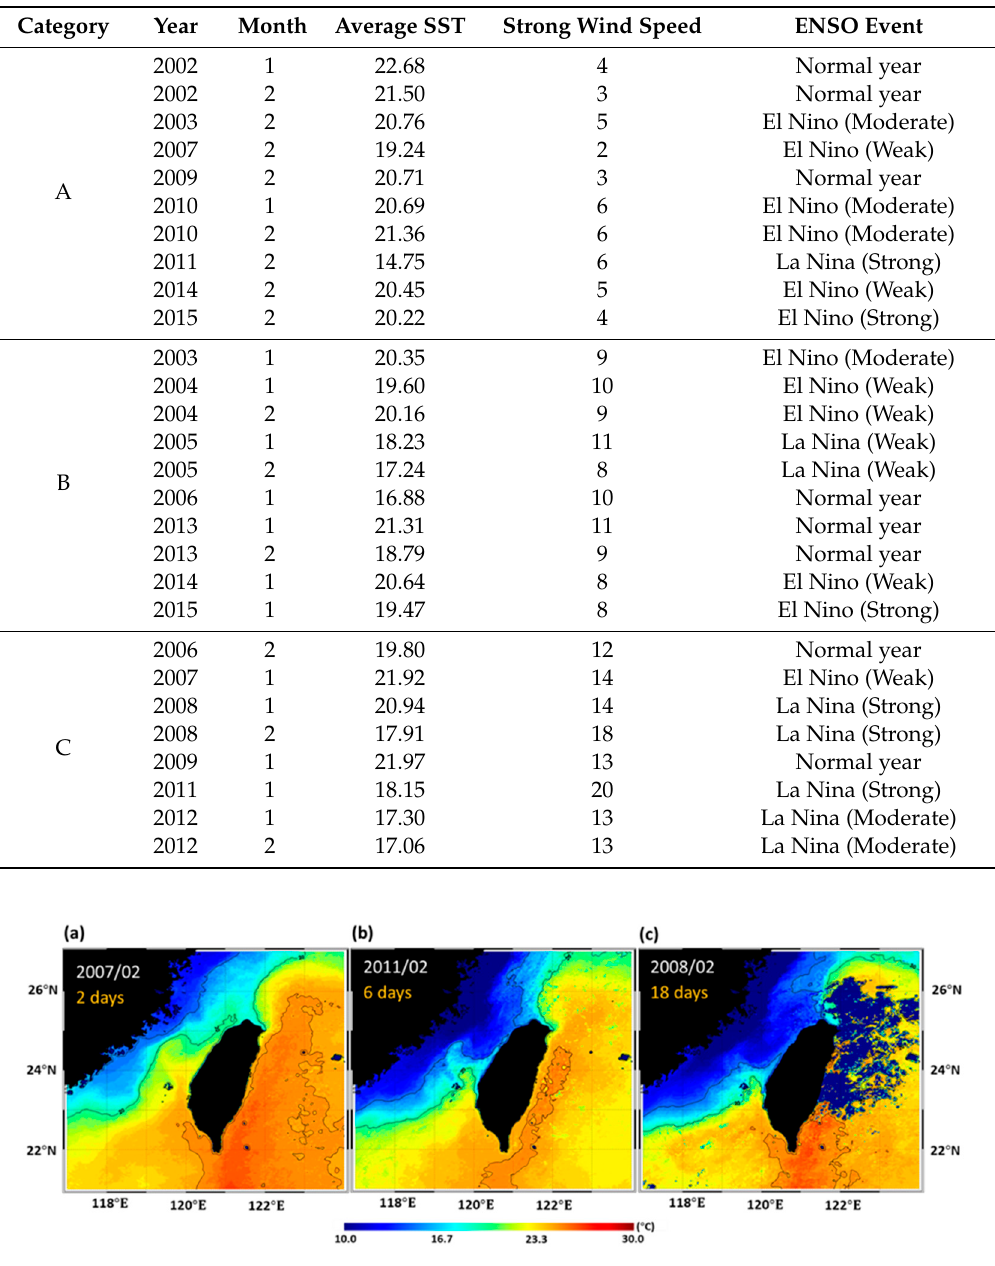
Table 2. The result of reclassification by strong speed wind days. Category A (the strong speed wind